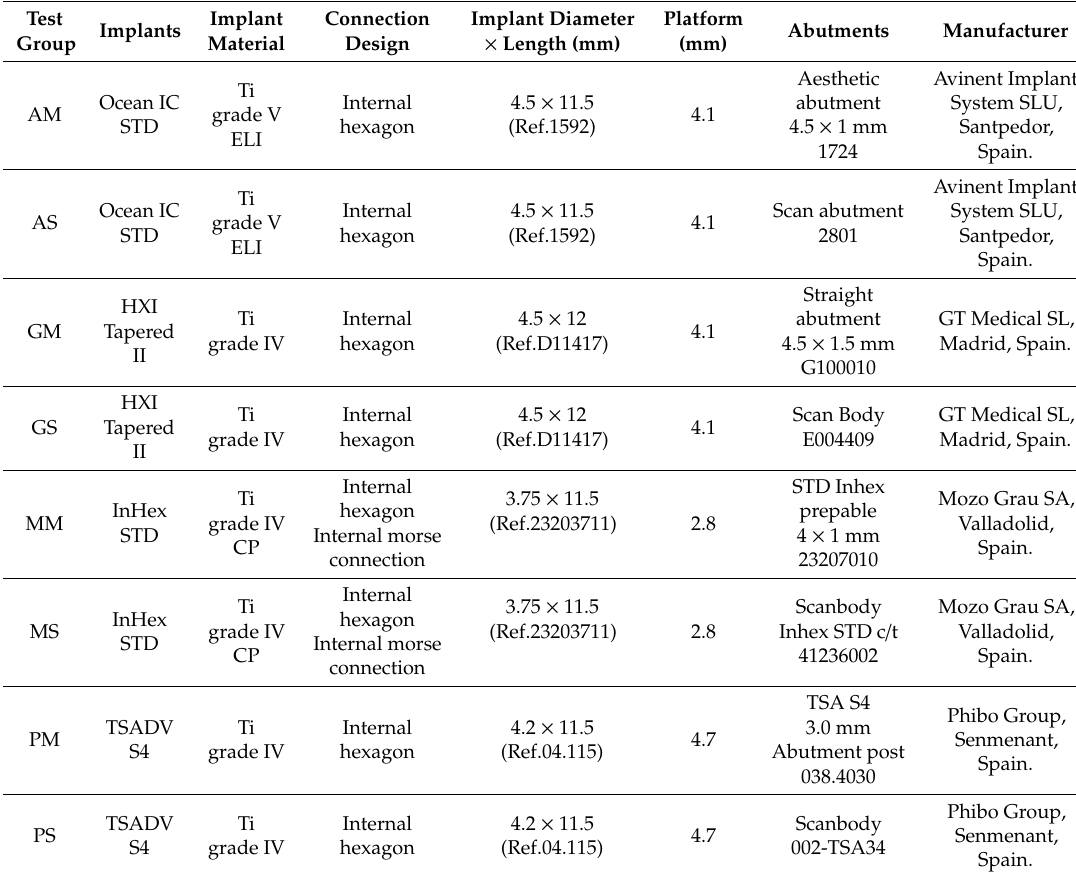
Table 1. Characteristics of the implants, abutments and scan bodies used. Test Group